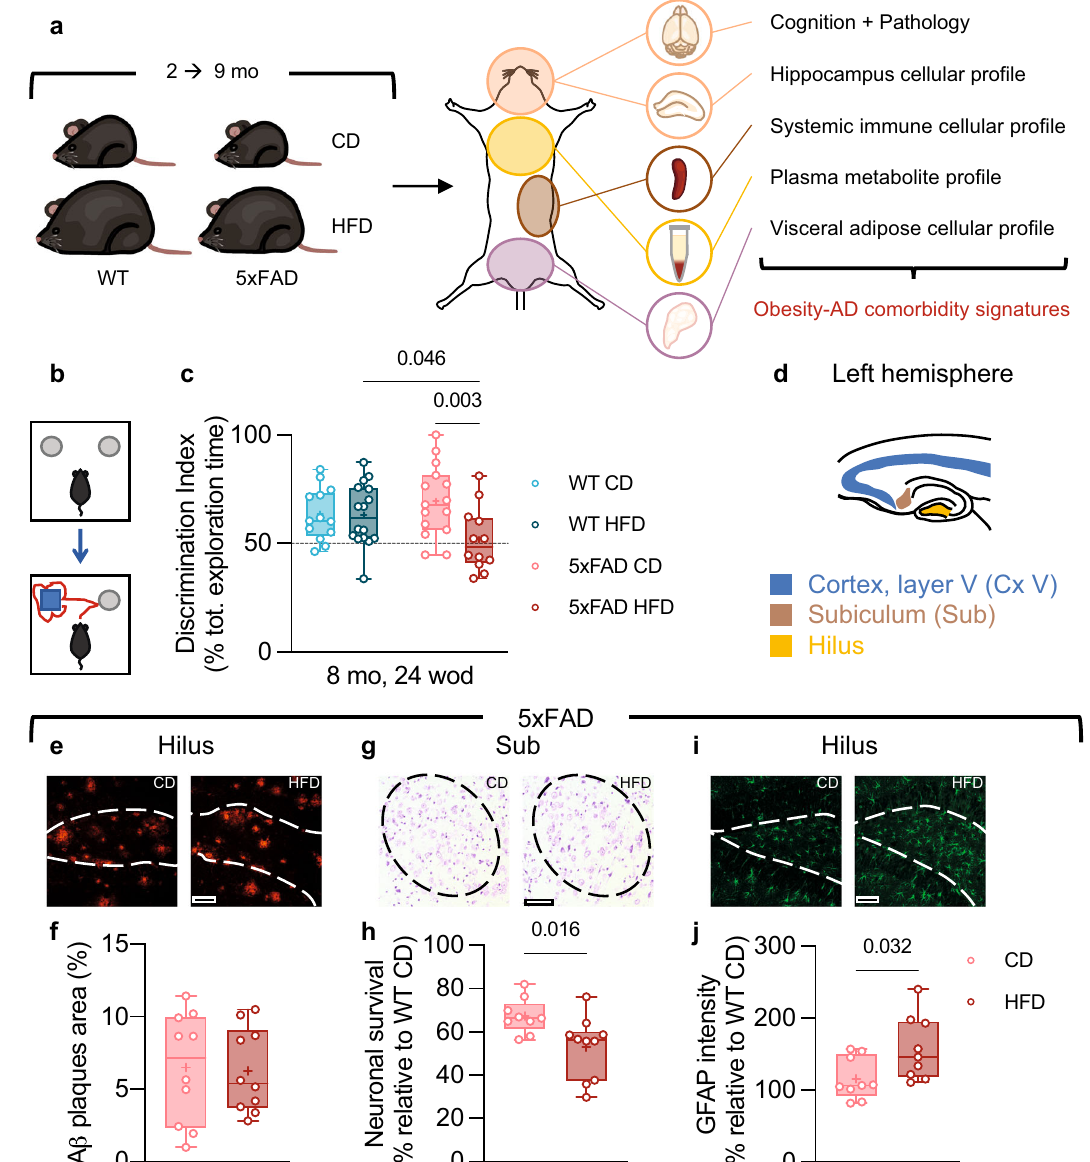
Fig. 1 | High-fatdietaccelerateddisease manifestations relative to controldiet in 5xFADmice. a Overview of the experimentalstrategy. a , c Reductioninnovelty discrimination in HFD-fed 5xFAD mice. Evaluation of cognition with the NOR test ( b ) at 8 mo, 24 weeks of diet (wod; c ). Mice from two independent experiments, sample n : WT CD=13, WT HFD=16, 5xFAD CD=15, 5xFAD HFD=12. Statistical analyses: two-way ANOVA followed by Fisher ’ s LSD post hoc test. d , Brain regions analyzedforhistopathology. e , f AssessmentofA β plaquesloadinthehippocampal hilus of 5xFAD mice. g , h Neuronal survival in the subiculum (Sub) of 5xFAD mice. i , j ,Glial fi brillaryacidicprotein(GFAP)-immunoreactivityinthehippocampalhilus